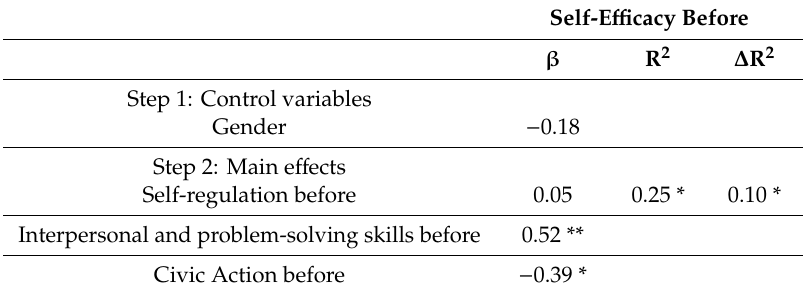
Table 3. Hierarchical regression analysis predicting self-e ffi cacy before